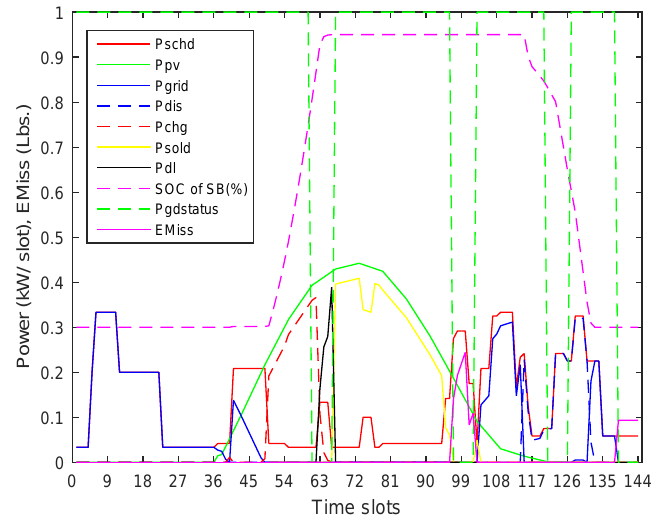
Figure 12. Power and emission profiles for DRSREODLDG-based HEMS operation for